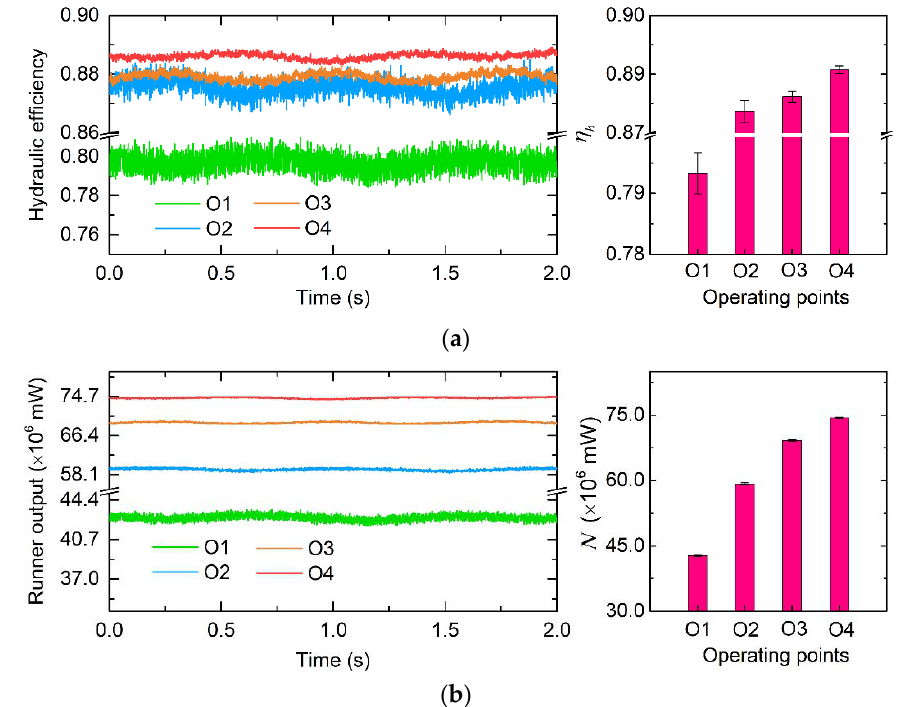
Figure 5. Runner efficiency ( a ) and output ( b ) under the four operating conditions. Figure 5. Runner e ffi ciency ( a ) and output ( b ) under the four operating